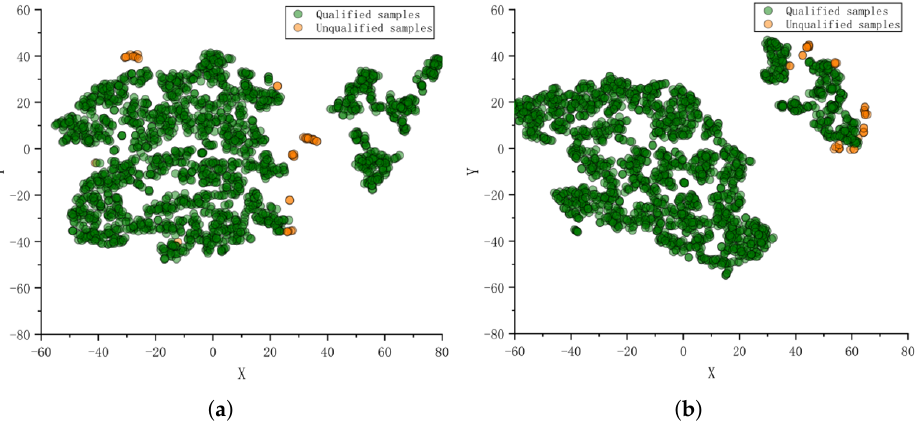
Figure 3. Thet-SNEvisualizationbeforeandafterdatapreprocessing. ( a )Notpreprocessing. ( b